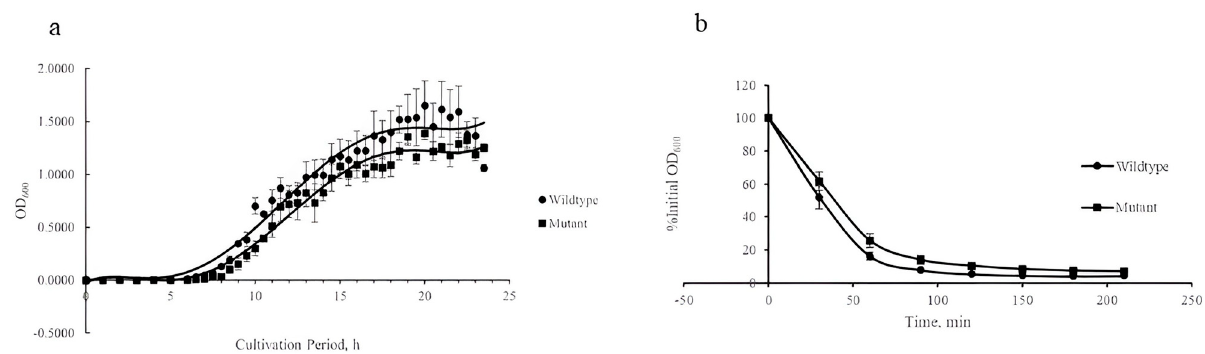
Figure 1. The influence of isaA on the growth patterns and autolysis profiles of S. aureus . ( a ) The ∆ isaA mutant and the parental strain SH1000 grown in RPMI medium with similar growth curves. ( b ) Autolysis curve for both bacterial strains, with autolysis activity expressed as percentage of the respective initial OD 600 .